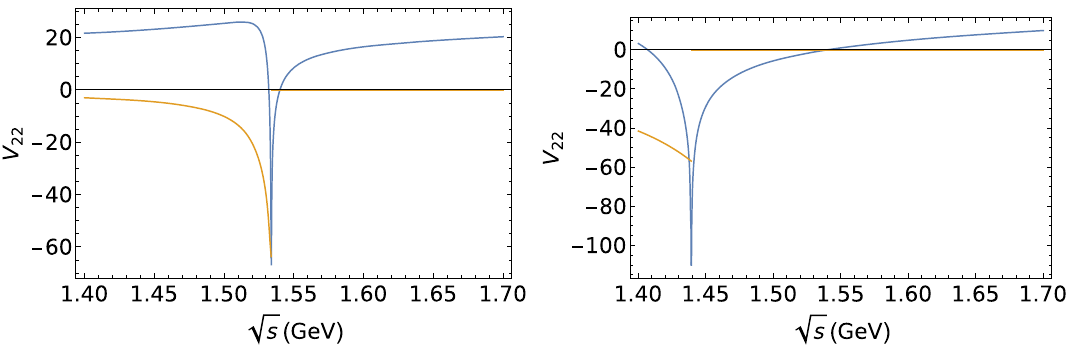
Fig. 4 Potential of ρω → ρω , the left one is π exchange and the right one is η exchange. The blue line is real part of the potential and the yellow line is imaginary part